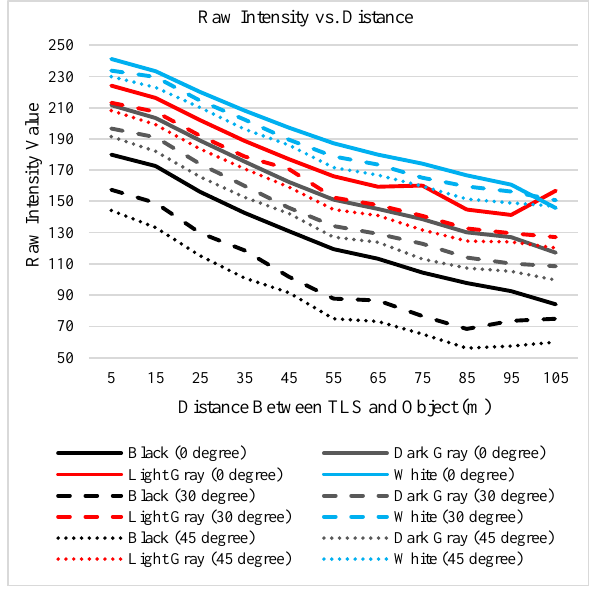
Figure 7. Raw intensity values Variation of intensity depending incidence angle, distance and surface properties are demonstrated in Figure